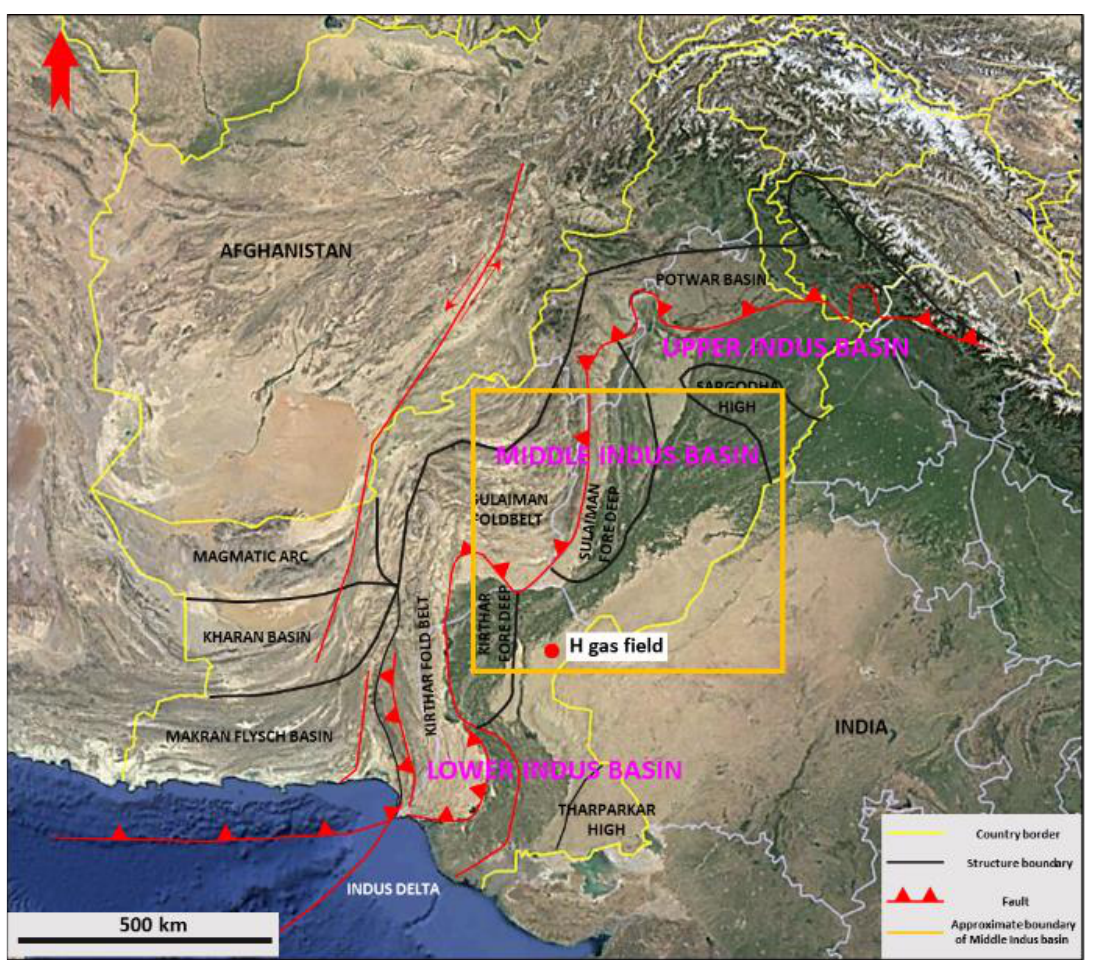
Figure 1. Regional structure map of Indus Basin. The whole Indus Basin is comprised by three subbasins: upper, middle, and lower Indus Basin. Miano gas field is located in the southwest corner of the middle Indus Basin, which is in the east of Kirthar foldbelt and the south of Sulaiman foredeep. The hydrocarbon-bearing interval in the Miano gas field only developed in the Lower Goru Formation, Early Cretaceous [9]. The hydrocarbon-bearing interval contains